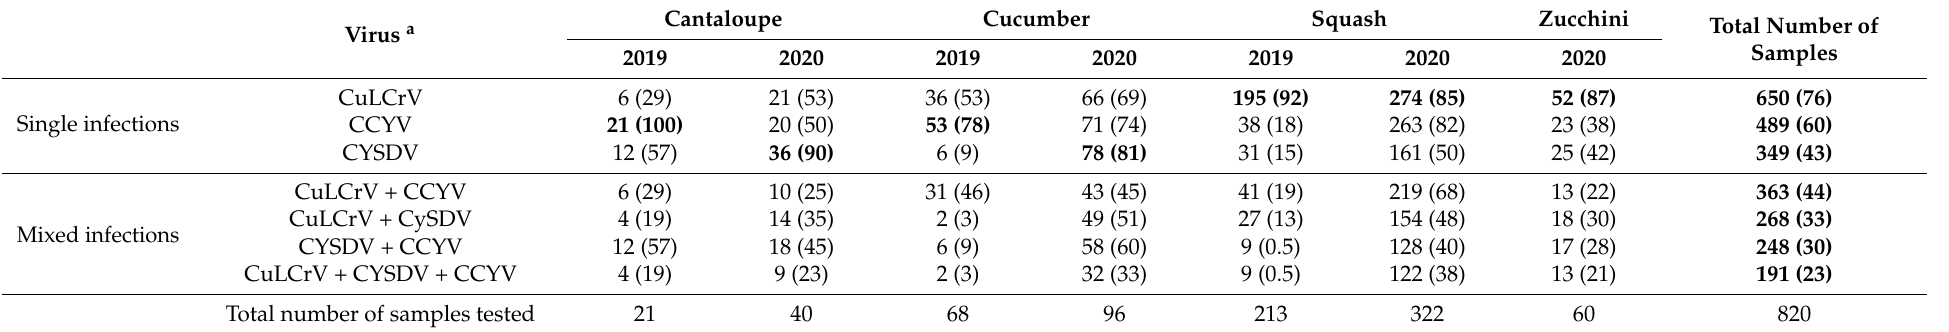
Table 2. Incidence of begomovirus and criniviruses on fall cucurbits in Georgia in 2019 and 2020. The number of samples in which a virus was detected and their percentages (in parenthesis) are presented. The numbers for the virus detected at the highest frequency on a crop in a particular year are shown in